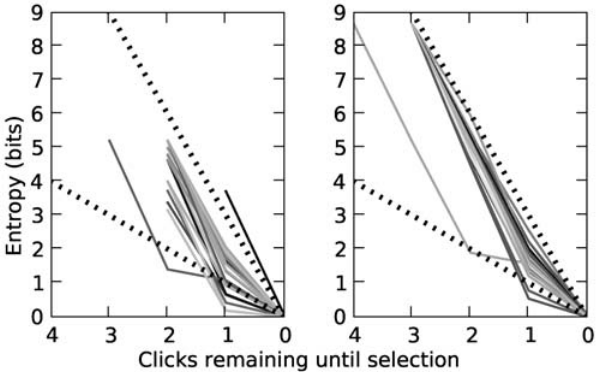
Figure 5. Entropy of the estimated probability distribution over clocks for two Nomon applications. Entropy is shown as a function of clicks remaining to selection. Each solid line represents a single selection process. Dotted lines decreasing to zero at respective rates of 1 (lower) and 3 (upper) bits per click are illustrated for reference. Left : 25 selections on the Nomon Keyboard: 30 clocks, non-trivial prior p c ð Þ , clock period 2 : 0 seconds, switch input from joystick button. Right : 25 selections on another Nomon application: 401 clocks, uniform prior p c ð Þ , clock period 2 : 0 seconds, switch input from space bar. Data was generated by the experienced user (TB).